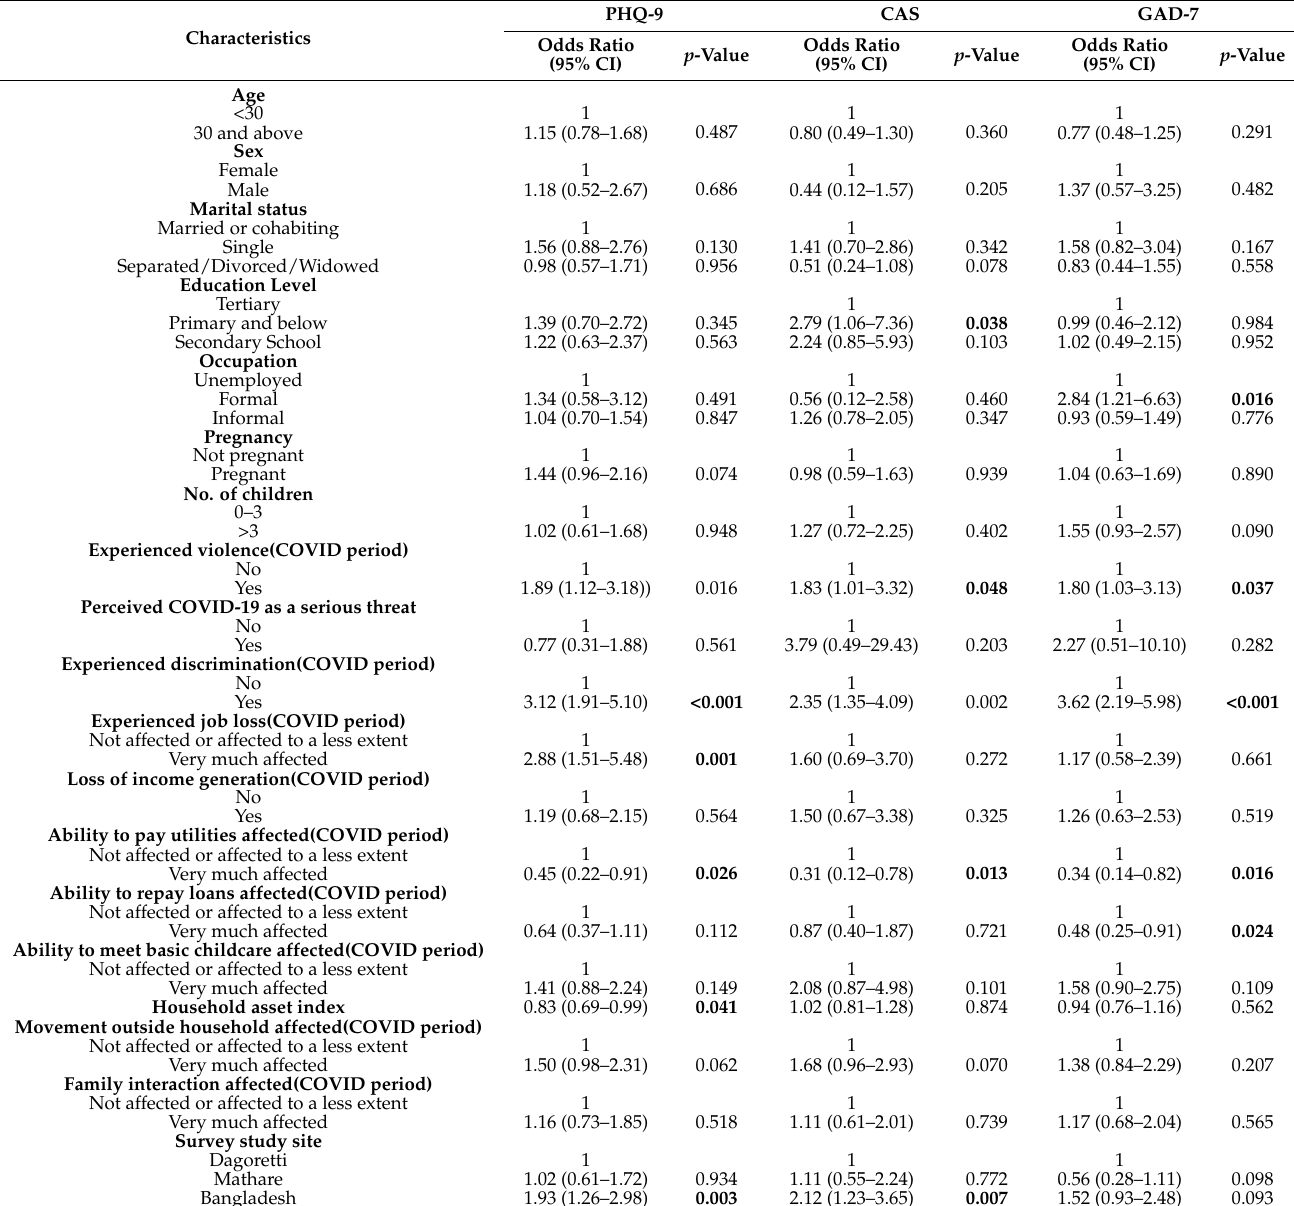
Table 3. Multivariate analysis of the relationship between socio-demographic factors, COVID-19-related consequences on psychosocial aspects, and participant’s mental health